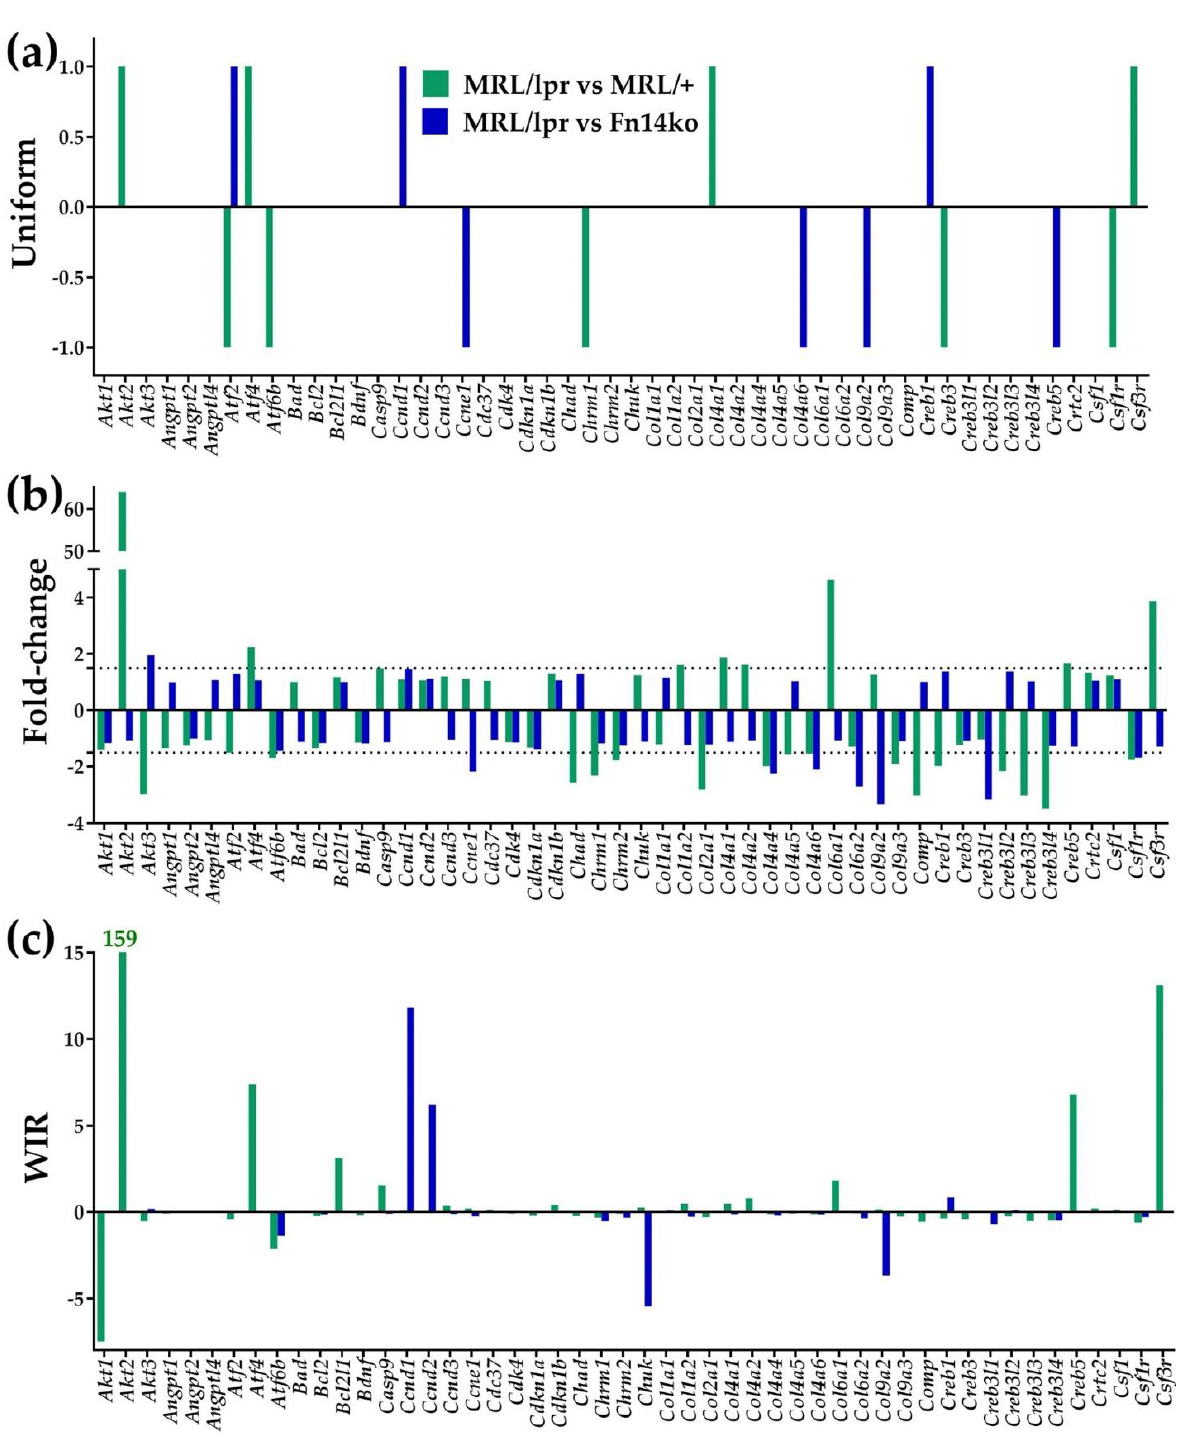
Figure 2. Measures of differential expression of the first 50 alphabetically ordered hippocampal PI3K-AKT genes in the MRL/lpr mouse with respect to the two controls. ( a ) Uniform contribution (+1 or −1) of the significantly regulated genes. ( b ) Fold-change (negative for down-regulation) of all genes within the selection. ( c ) Weighted Individual (gene) Regulation (WIR). In addition to the net fold-change, WIR considers also the reference expression level of the gene and the statistical confidence (1 − p -value) of its regulation. Taken together, it is a comprehensive measure of the relative contribution of the gene to the model’s transcriptome.